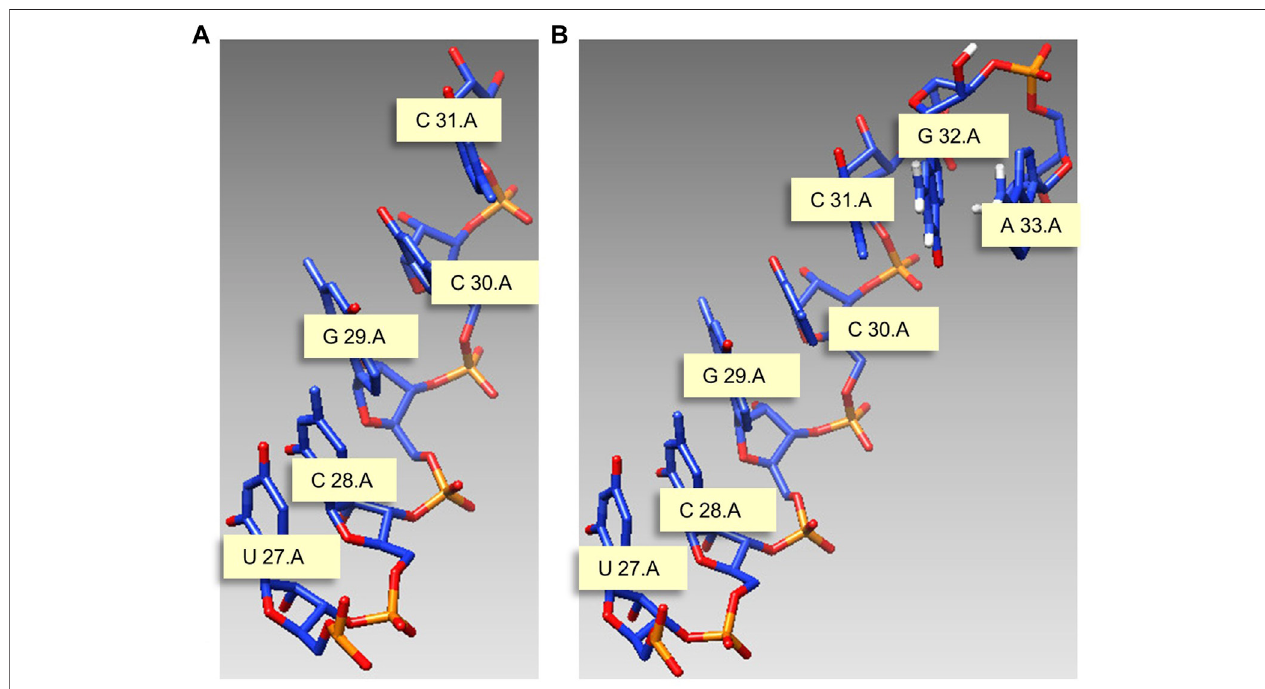
FIGURE5| Modelingexamplewith J31_glycine_riboswitch asmaterial. (A) Startstructure. (B) Predictedstructure.Meaningmarkedinthe fi gure:U27.Aindicates that the 27th nucleotide in chain A is U.